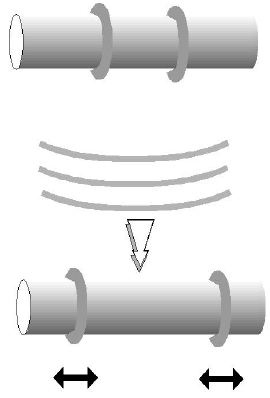
Figure 3. Sketch of the “sticky bead argument”.